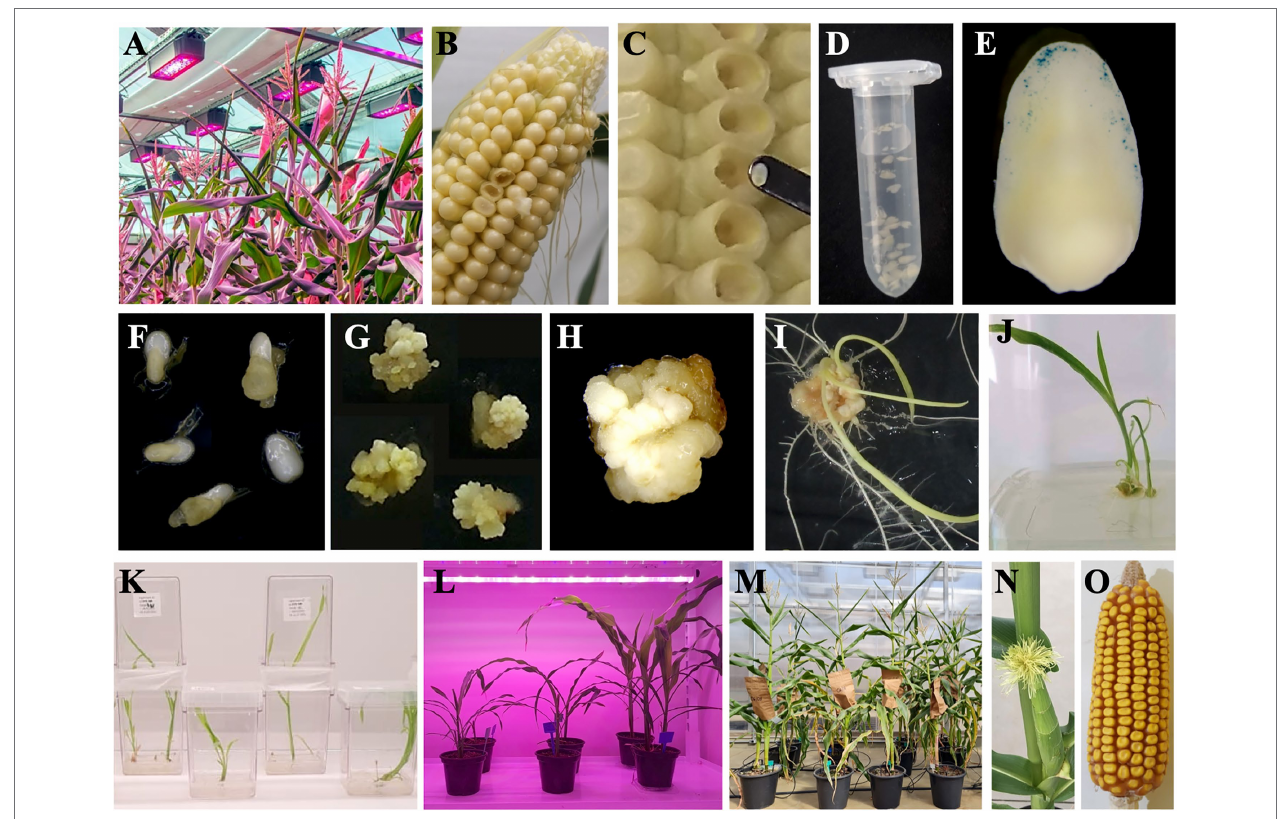
FIGURE 1 | Standard protocol for B104 maize transformation. (A) Growth of donor plants for immature embryo production under greenhouse-controlled conditions. (B) Ears are harvested 10–16 d after pollination. (C) The immature zygotic embryo reaches the ideal size of 1.2–2 mm. (D) Isolated immature embryos in co-cultivation. (E) Immature embryo transiently expressing the gus reporter gene. (F) Embryos in resting media seven days after Agrobacterium infection. (G) Calli induction on selection I medium. (H) Compact type I callus in selection II medium. (I,J) Regeneration of transformed plants. (K) Transformed plantlets with roots and shoots are grown in the penumbra room. (L) T 0 transgenic individuals rooted in the soil in an acclimation room. (M) T 0 plants grown at the greenhouse. (N) Flowering and pollination of T 0 plants at the greenhouse. (O) Harvesting of T 1 seeds. The complete process, from infection to T 1 seed production, takes approximately 6–8 months. The images are not to